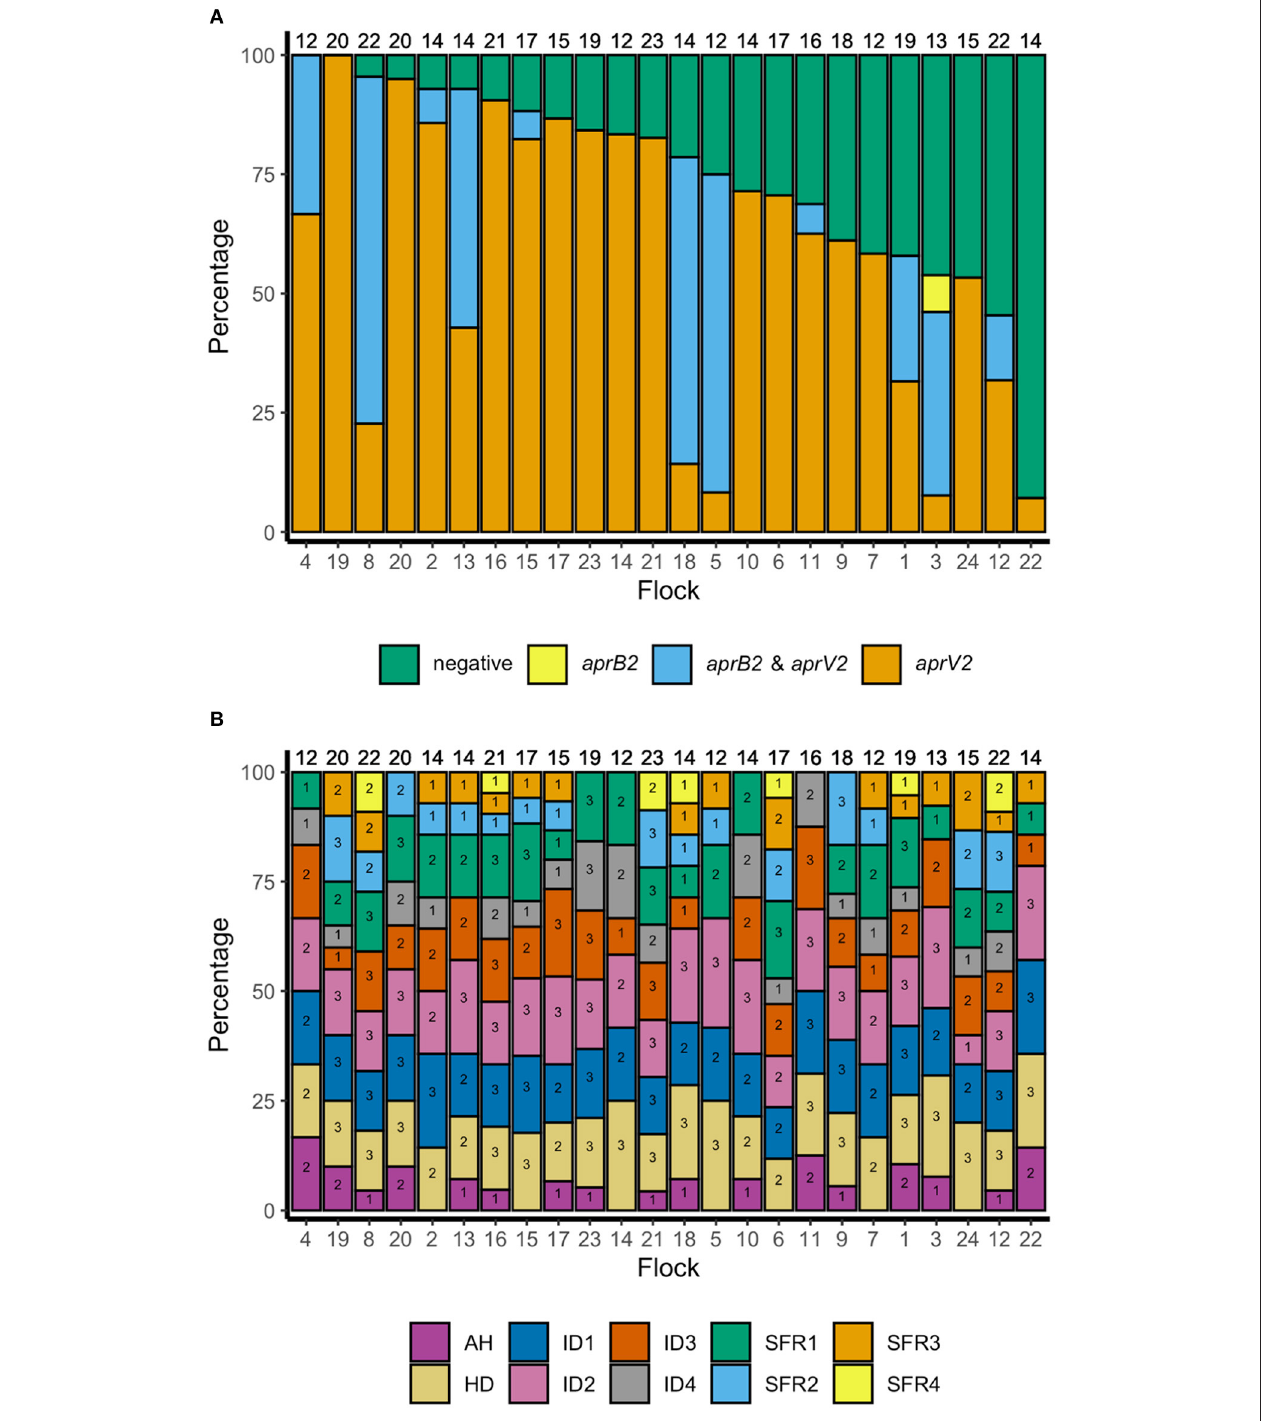
FIGURE 3 | (A) Percentage of samples negative for D. nodosus and positive for D. nodosus by aprV2 only, aprB2 and aprV2 and aprB2 only in descending order of aprV2 only: 395 pooled samples from 24 flocks in England. Number at top of each bar = number of pooled samples over three visits, number at the bottom = flock identification. (B) Percentage of samples positive by foot phenotype: 395 pooled samples from 24 flocks in England. Top of column number = total number of pooled samples per flock for all three visits. Number within each bar = number of pooled samples per flock for all three visits by foot phenotype. AH, all healthy feet from sheep where all four feet were healthy; HD, Healthy feet from sheep where one or more feet had signs of footrot; ID, Interdigital dermatitis scores 1–4; SFR, Severe footrot scores 1–4. Number at base of bar = flock identification number, ordered as for (A) .